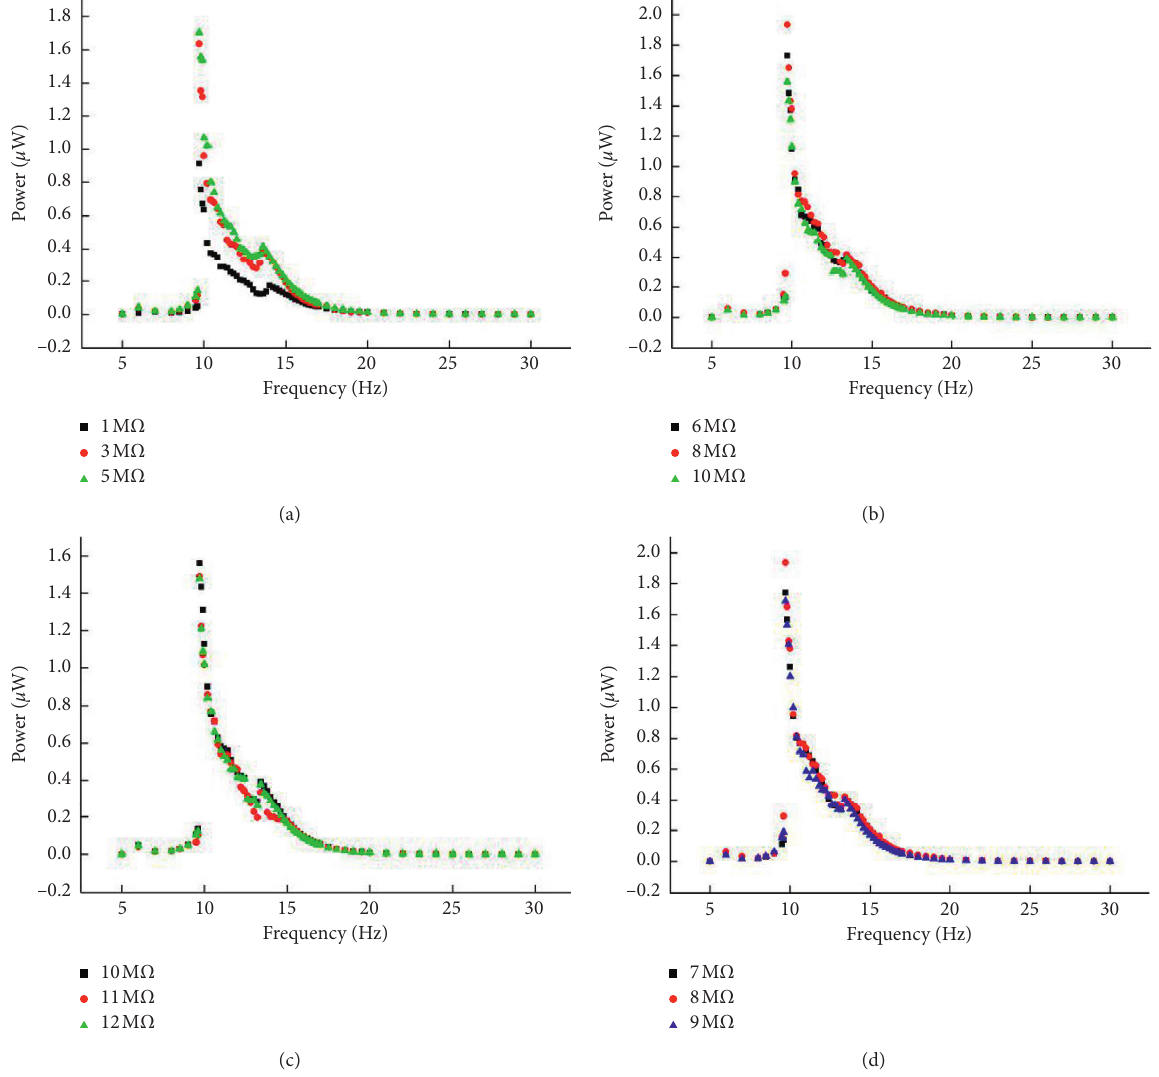
Figure 31: Relation of the power-frequency of different external loads is given: (a) external loads are 1 M Ω ,3M Ω , and 5 M Ω , respectively; (b) external loads are 6M Ω , 8 M Ω , and 10M Ω , respectively; (c) external loads are 10M Ω , 11M Ω , and 12M Ω , respectively; (d) external loads are 7 M Ω , 8M Ω , and 9M Ω ,